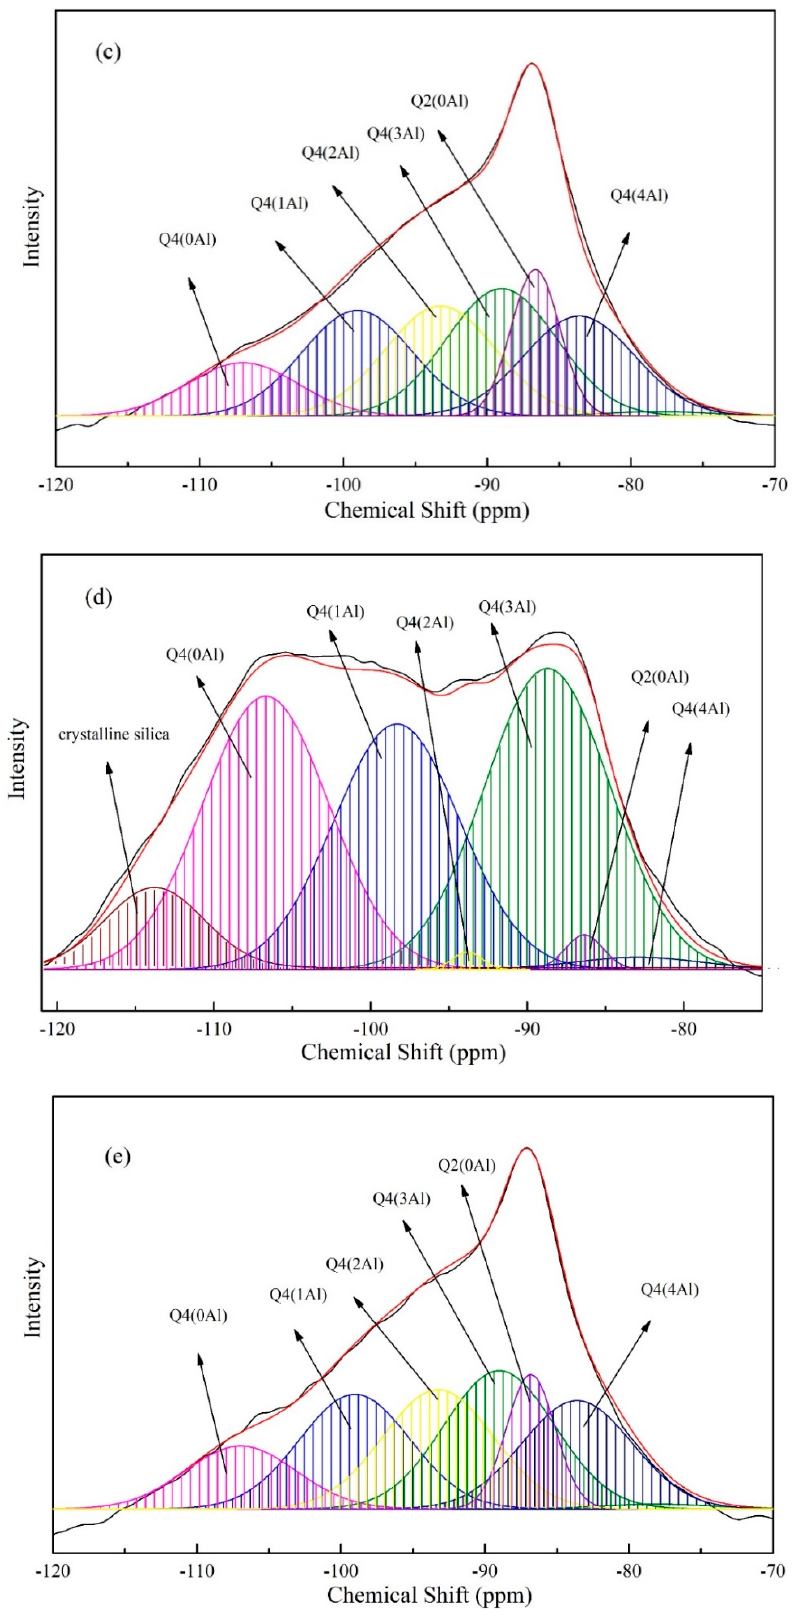
Figure 5. 29 Si NMR spectra ( a ) and their deconvolution of geopolymers with synthesized with different alkali activators, No. 1 ( b ), No. 6 ( c ), No. 8 ( d ) and No. 13 ( e ).